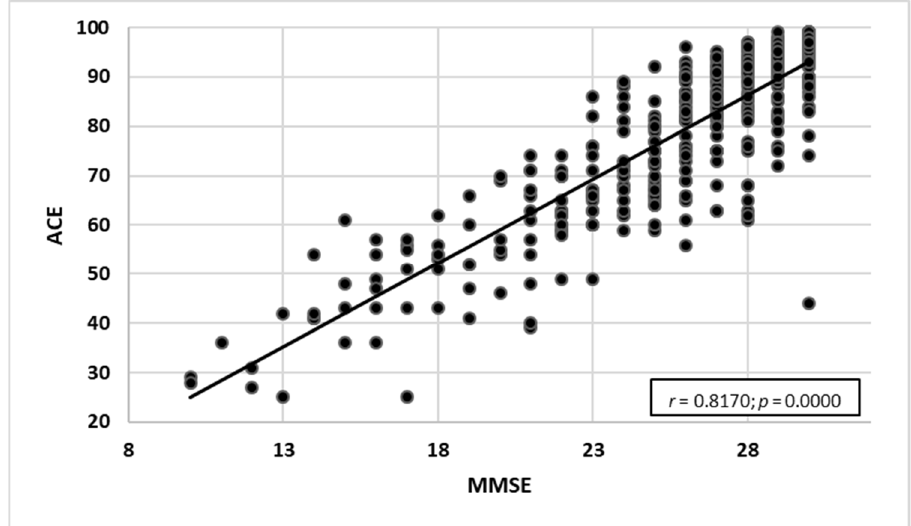
Figure 7. MMSE test results correlated with ACE-III test results ( n = 386).